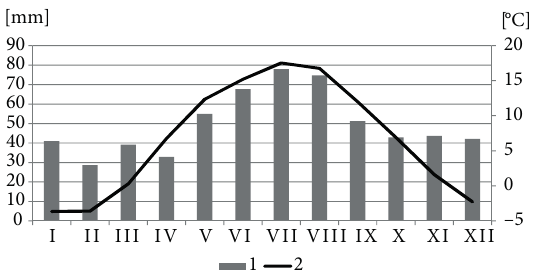
Fig. 2. Monthly sums of precipitation and monthly mean temperatures observed at the meteorological station in Suwałki over the period 1980–2012. Key: 1 – sum of precipitation;